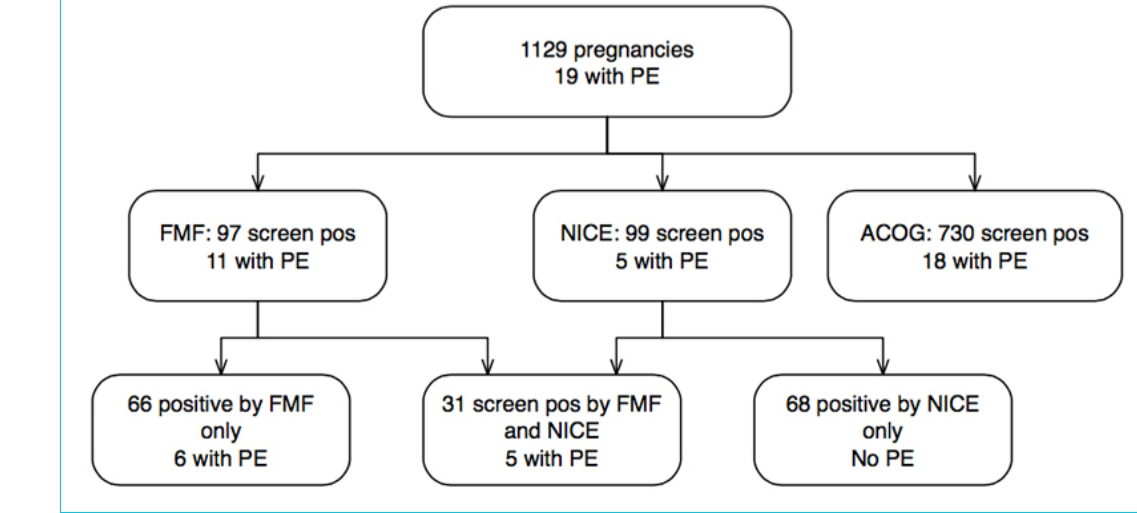
Figure 2: Performance of preeclampsia (PE) screening in Bern by use of first trimester combined screening according to the Fetal Medicine Foundation (FMF) London, compared with screening by anamnestic risk factors as proposed by the UK National Institute for Health and Care Excellence (NICE) and American College of Obstetrics and Gynecology